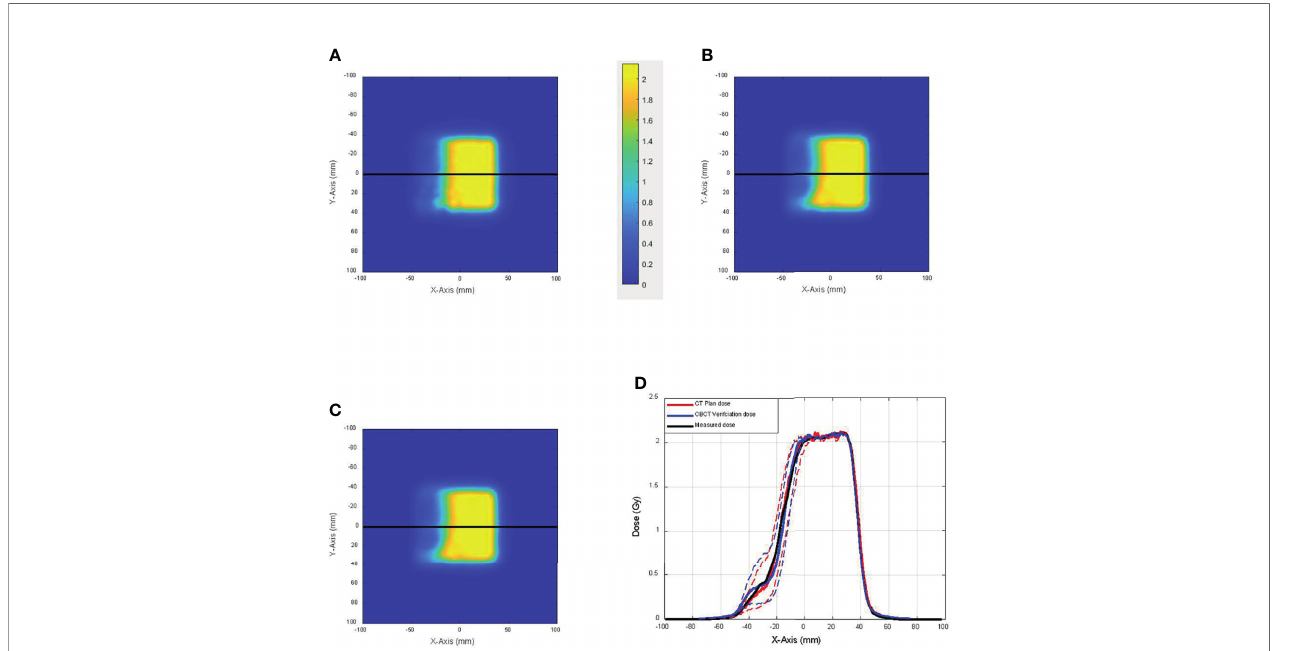
FIGURE 6 | The comparison among 2D planes extracted from the 3D dose calculated on (A) CT and (B) cone-beam CT (CBCT) that best match (C) the 2D plane measurement. (D) Dose pro fi le of panels A – C (solid lines) and dose pro fi les from CT and CBCT dose planes that were 3 mm proximal and distal toward the best- matched dose planes (dashed